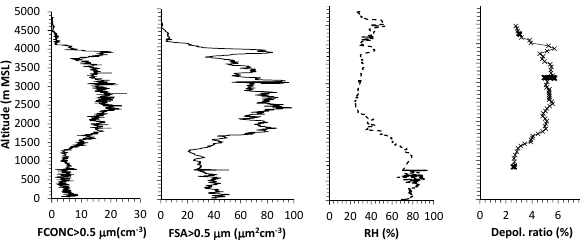
Figure 4. Vertical profiles during descent sounding by C-130 air- craft on 4 July 2011 during the ICE-T study. Panels from left to right, respectively, are FSSP-300 ambient particle concentrations in clear air at optical diameters larger than 0.5µm, FSSP-300 surface area in the same size range, relative humidity, and lidar linear depo- larization